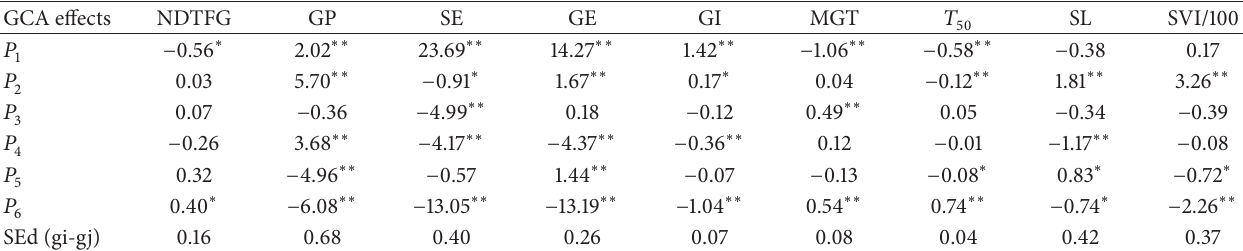
Table 3: GCA effects for nine germination traits of 6 × 6 diallel populations in Jatropha curcas . GCA effects